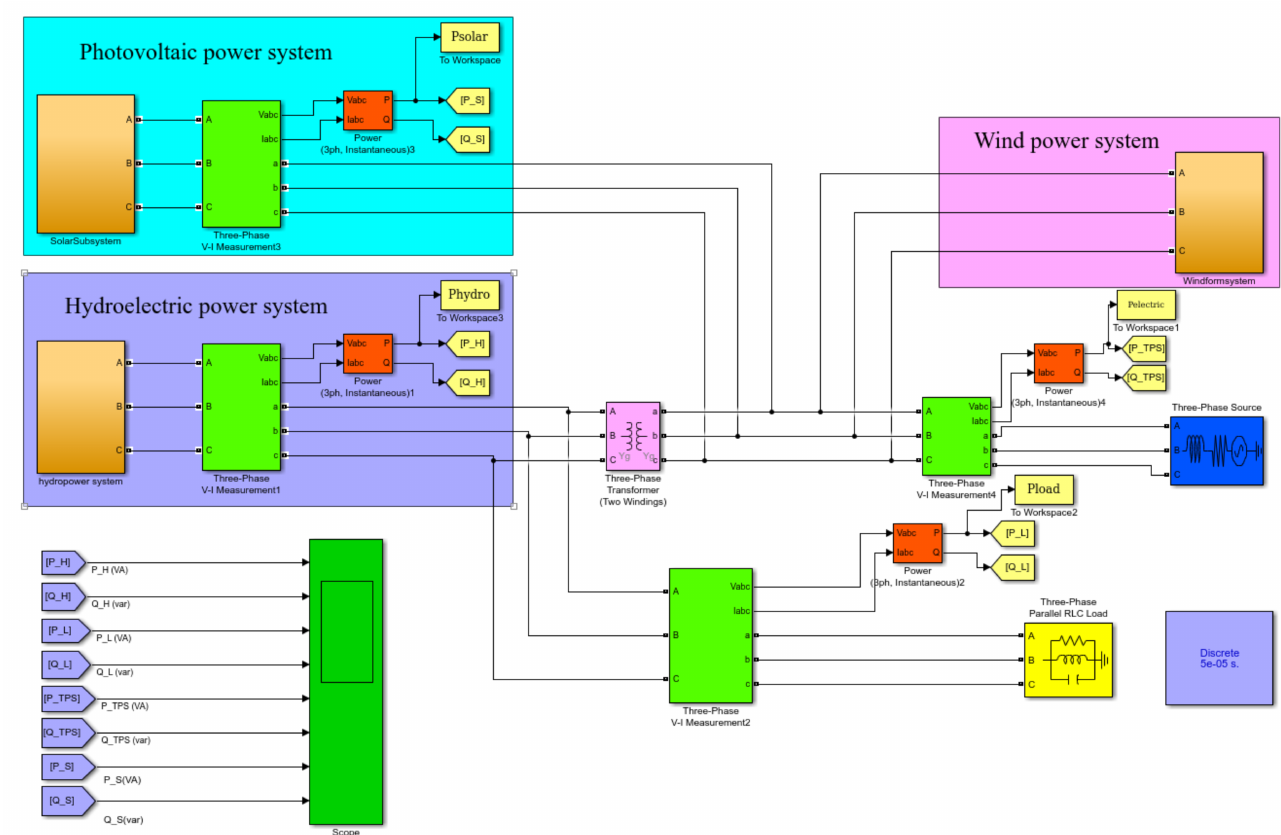
Figure 12. Block diagram of the wind/solar/hydropower integrated power